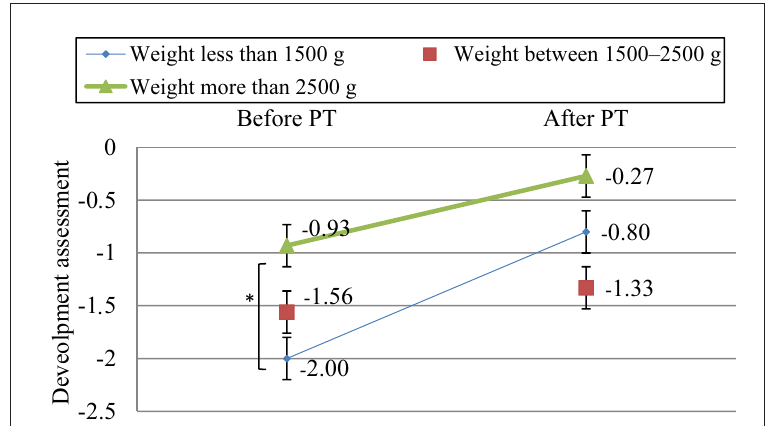
Note. * – significant differences between groups p <